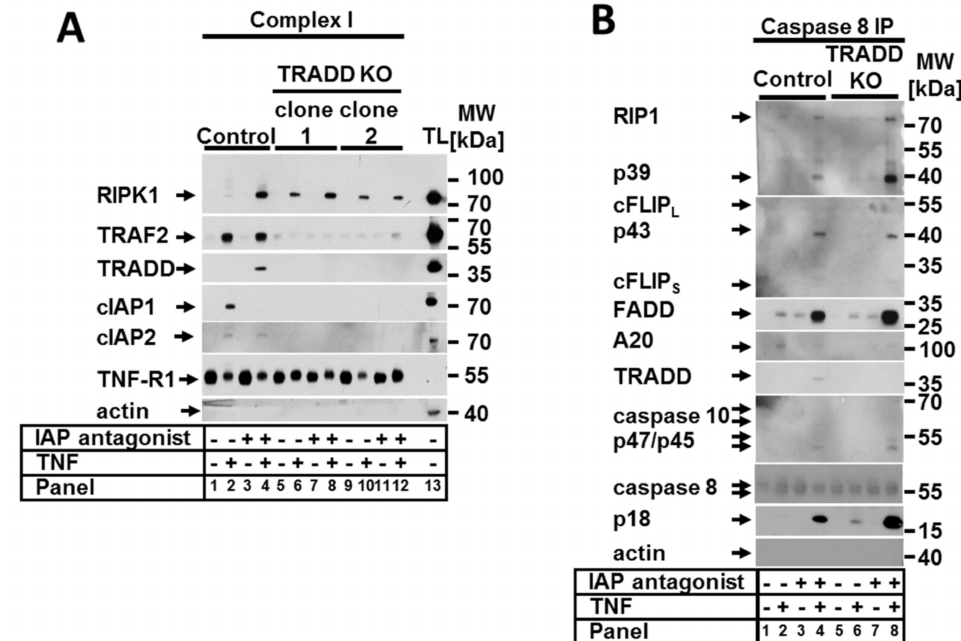
Figure 5. TRADD was critical for complex I formation but irrelevant for ripoptosome formation. Control and TRADD KO cells were stimulated as indicated. ( A ) TNF complex I and ( B ) caspase-8 immunoprecipitation (IP) were performed as described in Section 4. Recruited proteins were analyzed by WB. The WB shown are representative of at least two independent